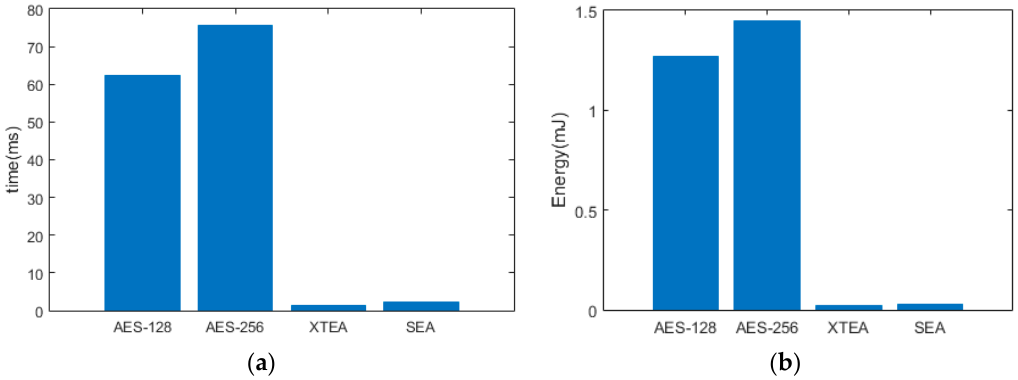
Figure 11. Comparative metrics for a 32-bit MCU: ( a ) Execution time; ( b ) Energy consumption.